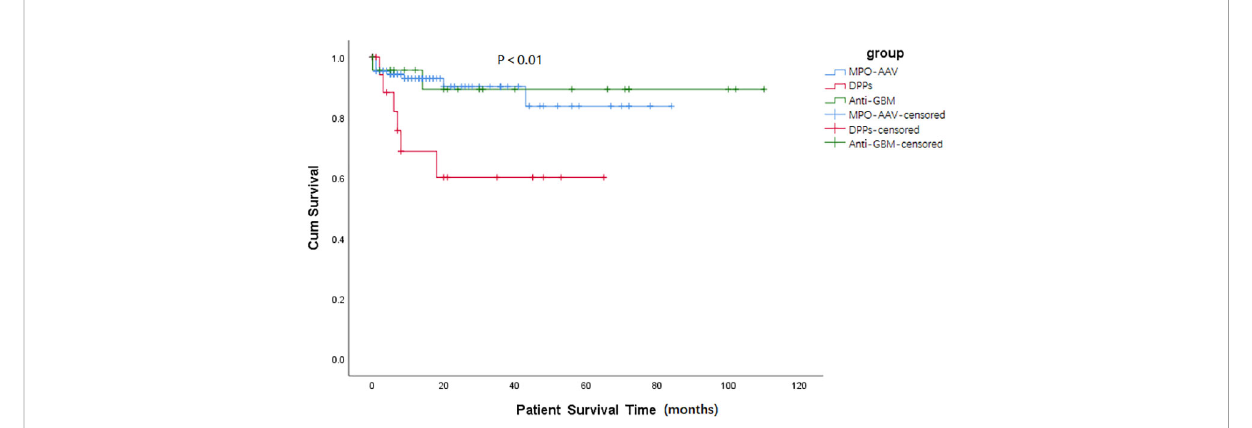
FIGURE 2 Kaplan-Meier survival functions describing long-term patient survival states of three groups. Patient survival time (months) refers to the time since the start of treatment. p = 0.853, MPO-AAV vs. Anti-GBM; p = 0.006, MPO-AAV vs. DPPs; p = 0.055, DPPs vs.